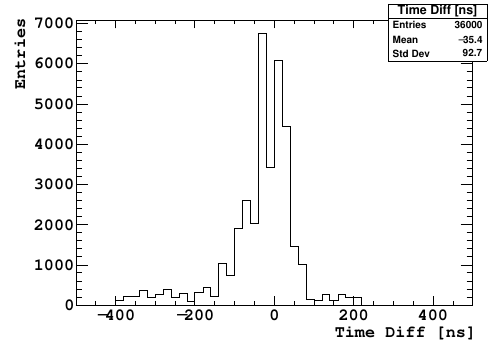
Figure 8. Time di ff erence between pulser for FD trigger and pulser for light source.